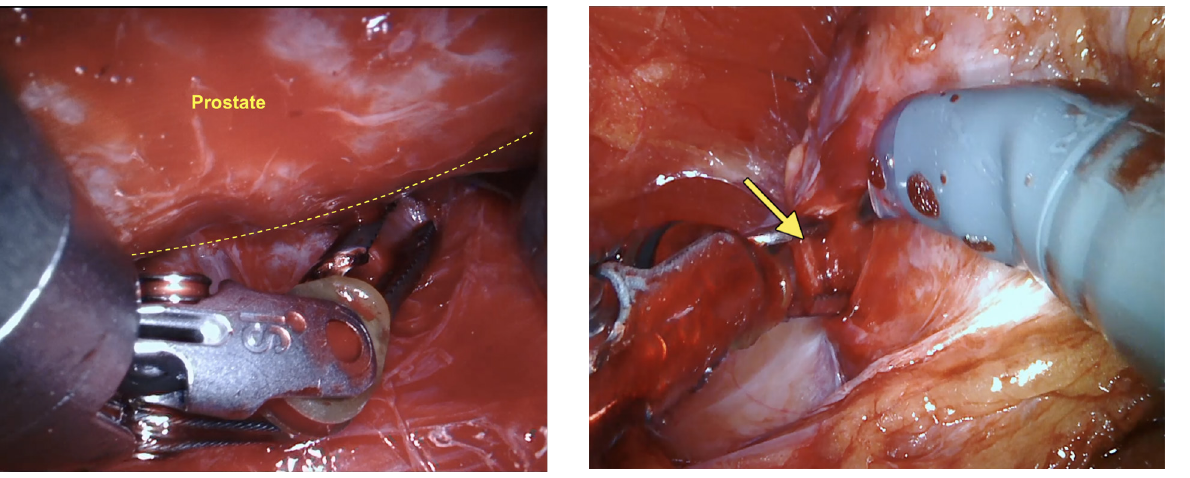
Figure 4 - Left endopelvic fascia opening at the lateral aspect of the prostate, searching for the anteromedial prostatic artery.